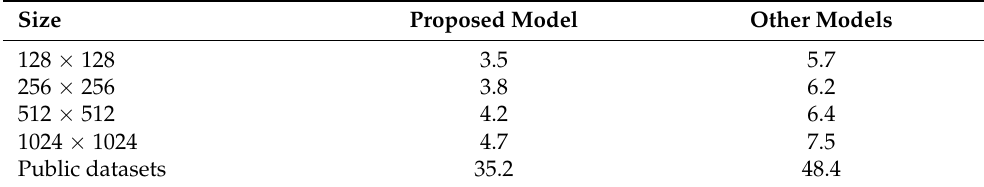
Table 5. Expected performance—computing times (in ms) compared with those of other models.